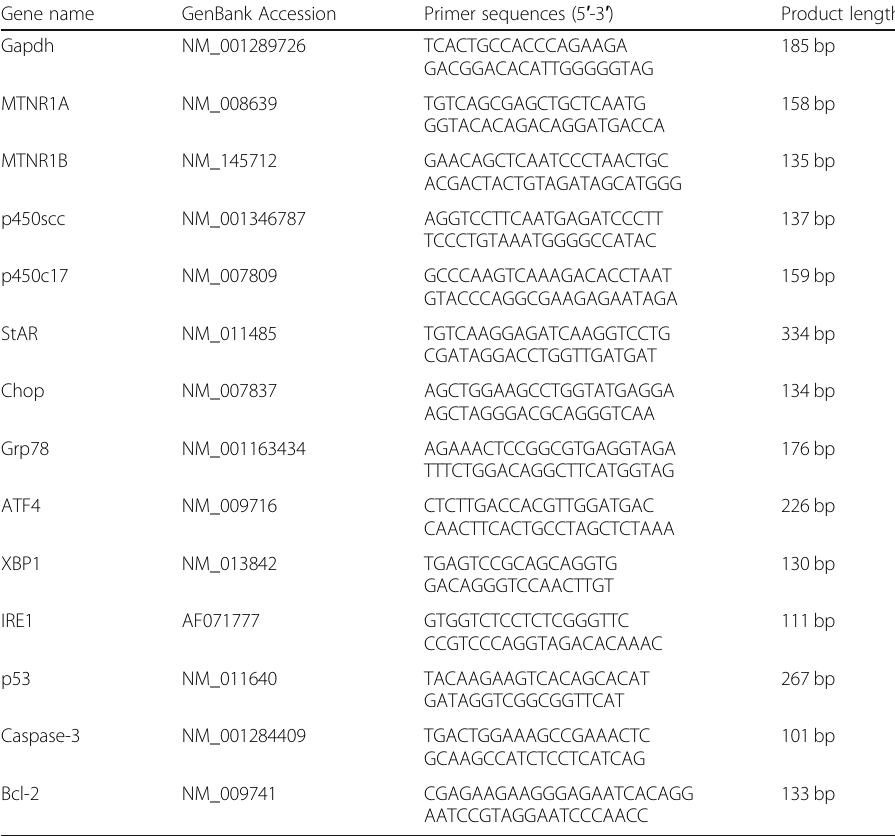
Table 1 Primer sequences used for qPCR analyses of gene